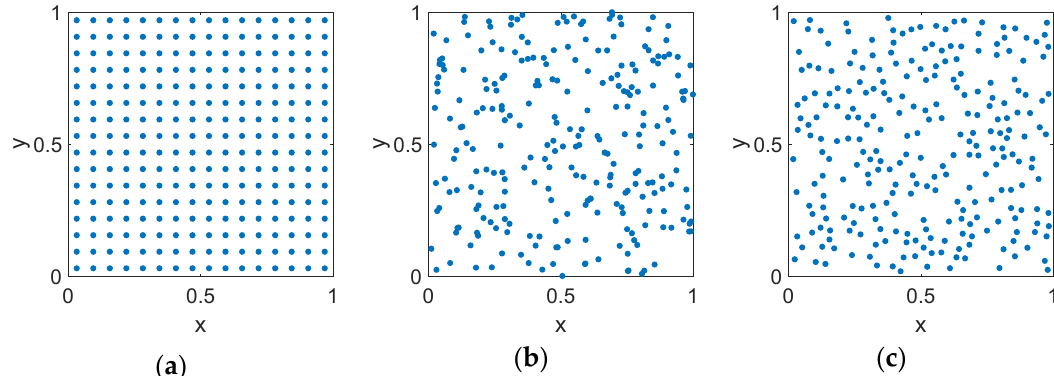
Figure 2. A generic representation of the position of points on a unit-square with different distributions: ( a ) uniform, ( b ) random, ( c ) LDS Poisson disk. The total number of elements is equal in all three cases but note that the LDS method fills the space more uniformly while avoiding too close spacings.